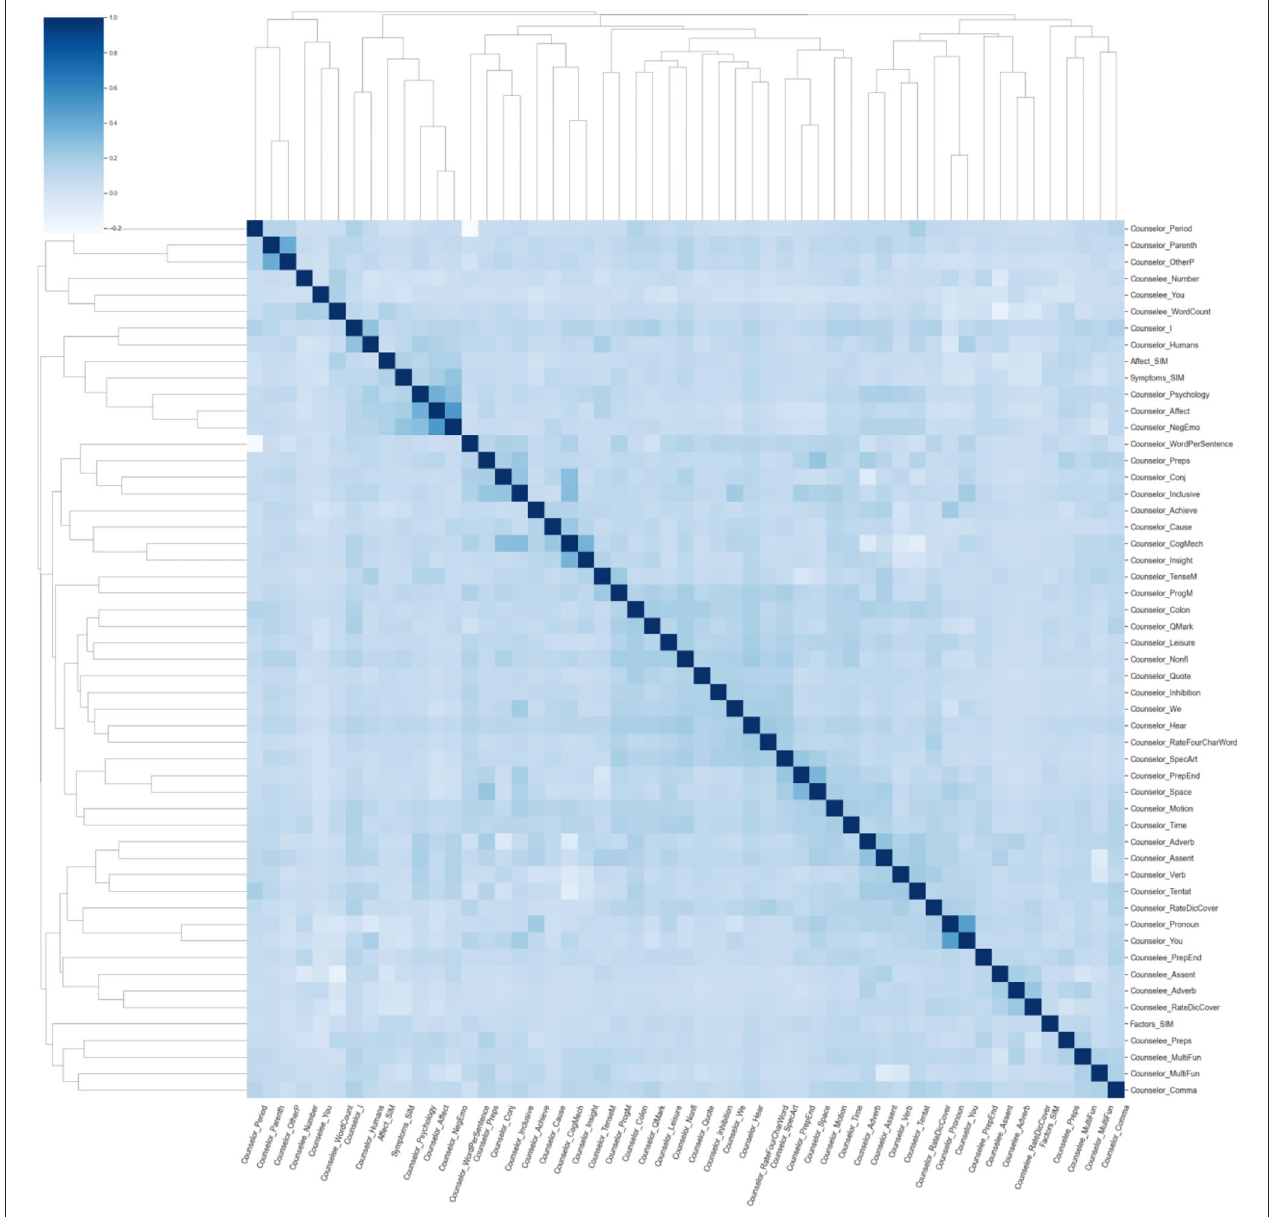
FIGURE 3 | The clustering diagram based on SHAP value of the influential